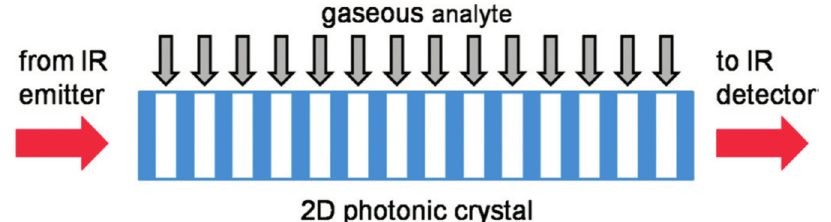
Figure 7. Schematic diagram of a typical 2D photonic crystal gas sensor. The light impinging from the left side is absorbed by the gas molecules inside the photonic crystal. Due to the reduced group velocity, the interaction path is effectively reduced. Reprinted with permission from Reference [71]. Copyright 2011 AIP Publishing,